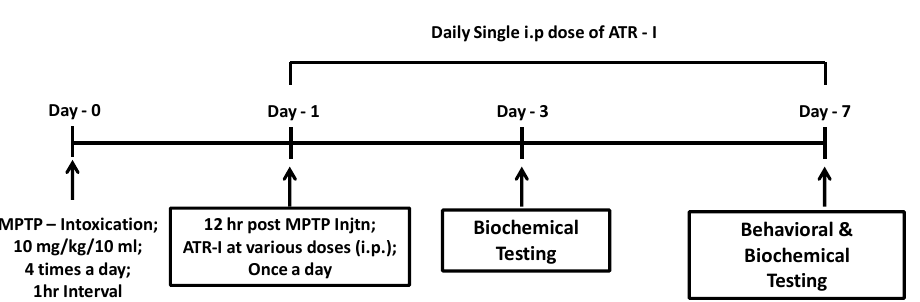
Scheme 1. Experimental design illustrating the treatment and testing schedule for animal experiments.